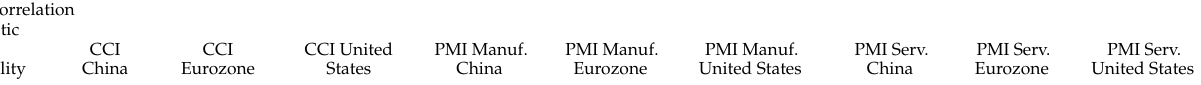
Table A1. Economic sentiment indicators correlation